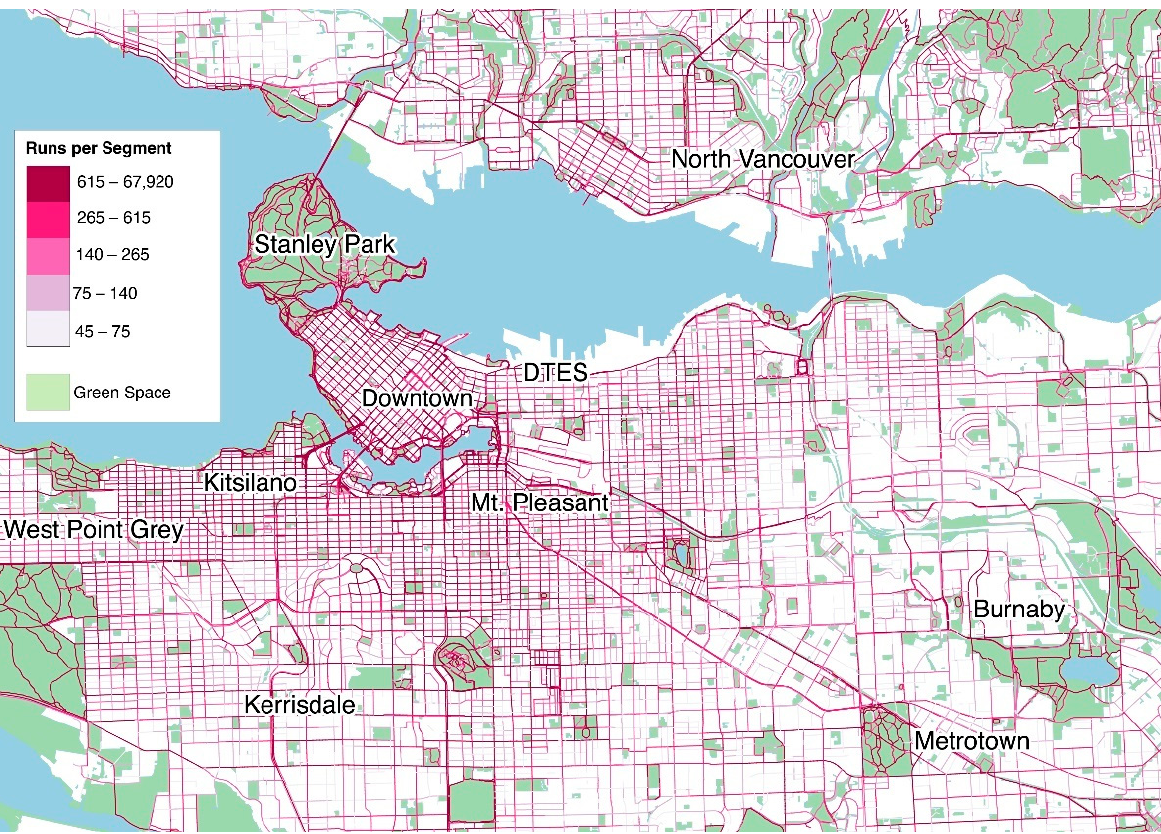
Figure 2. Distribution of Strava running activities in of Metro Vancouver. The majority of runs are observed in Downtown Vancouver and surrounding areas.